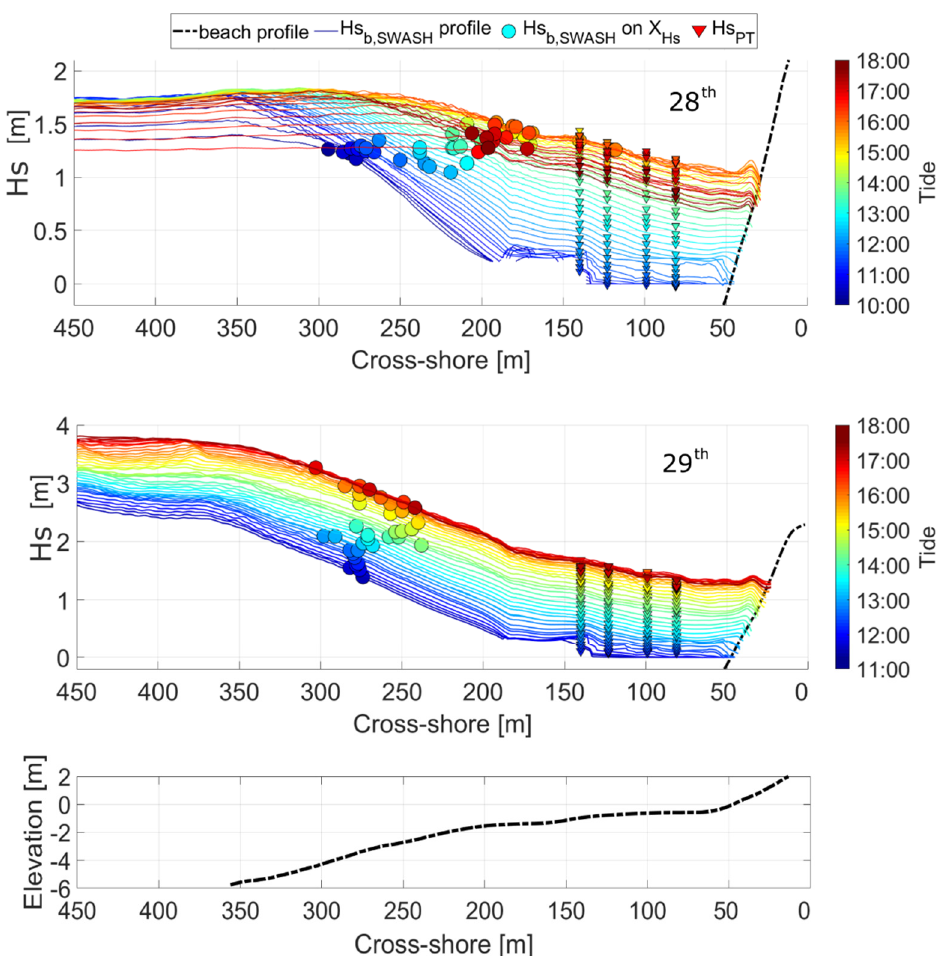
Figure 10. SWASH model results for the two days. Circles show the Hs b , SWASH extracted at X Hs , which were found from video data at the corresponding time interval. Triangles show Hs measured by PTs at their cross-shore locations. The legend at the top is common both graphs. The related beach profile transect is shown at the bottom of the figure.